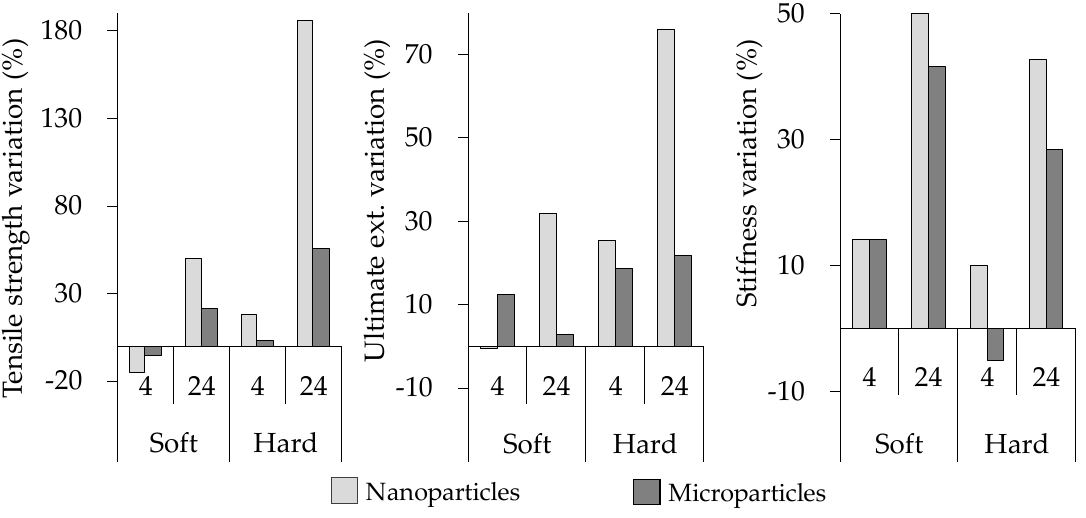
Figure 4. Mechanical properties variation of the reinforced material with micro- and nanoparticles with respect to the bare material.